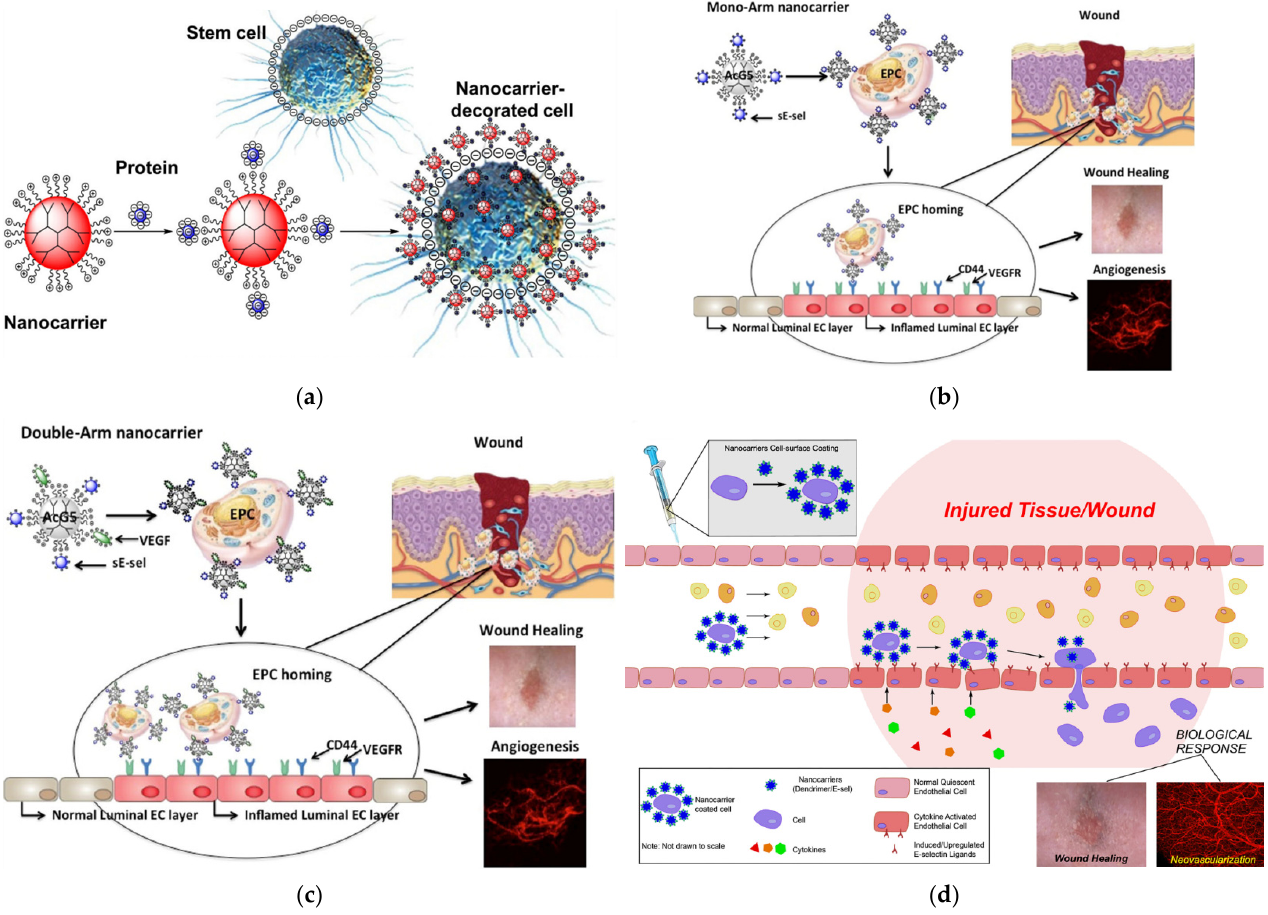
Figure 31. ( a ) Schematic illustration for the design of a nanocarrier for cell coating; Representative scheme of the dendritic polymer functionalization for the desired ( b ) “Mono-arm” biological readout. (Ac-G5-PAMAM-sE-sel) and ( c ) “double-arm” biological readout. (Ac-G5-PAMAM-sE-sel/VEGF) for endothelial progenitor cell coating. ( d ) Illustration of this novel targeted systemic cell delivery system. The cell surface is coated with nanocarriers composed of dendrimers conjugated with adhesion molecules. These nanocarriers guide coated cells homing to the desired tissue via association with the counterpart molecules highly or selectively expressed on the endothelium of diseased